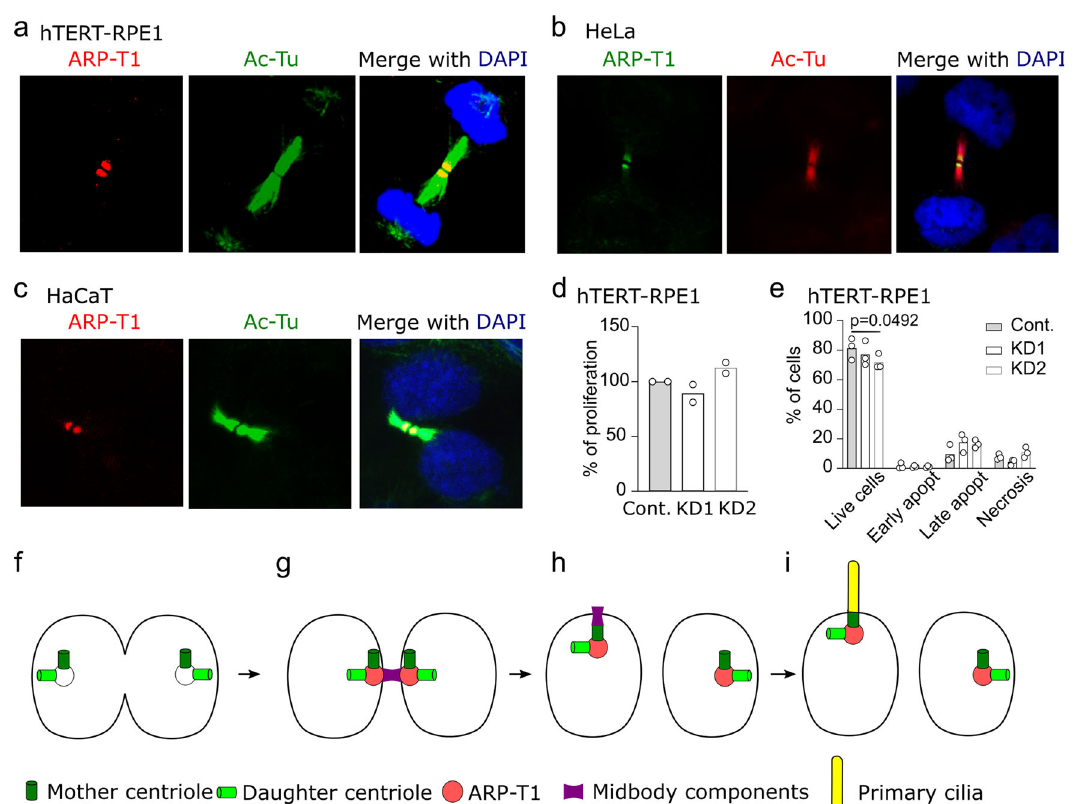
Fig. 5 ARP-T1 localizes to midbody during cytokinesis. a Immuno fl uorescence stainings of ARP-T1 (red) and acetylated-tubulin (green) in hTERT-RPE1 cells. Cell nuclei are stained with DAPI (blue). b Immuno fl uorescence stainings of ARP-T1 (green) and acetylated-tubulin (red) in HeLa cells. Cell nuclei are stained with DAPI (blue). c Immuno fl uorescence stainings of ARP-T1 (red) and acetylated-tubulin (green) in HaCaT cells. Cell nuclei are stained with DAPI (blue). d , e Proliferation ( d ) and apoptosis ( e ) analyses of control (Cont.) and ACTRT1 KD hTERT-RPE1 cells. Data are presented as means of the percentage. Each open circle represents one independent experiment. f – i Model for ARP-T1 traveling from midbody to the primary